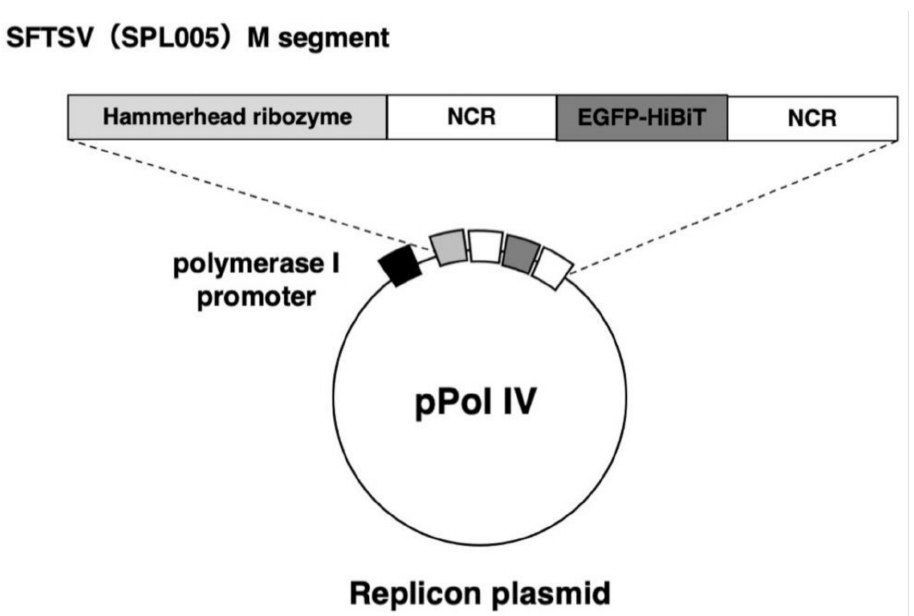
Figure 1. Schematic representation of cRNA-oriented pol I-driven minigenome. The reporter minigenome was composed of a reporter gene, eGFP, C-terminally tagged with HBT, flanked by the 3 (cid:48) (leader) and 5 (cid:48) (trailer) noncoding regions of SFTSV. They were flanked by hammerhead ribozyme (HamRz) sequence at the N-terminus. These transcription cassettes were then cloned between the transcriptional start and stop signals of the human RNA pol